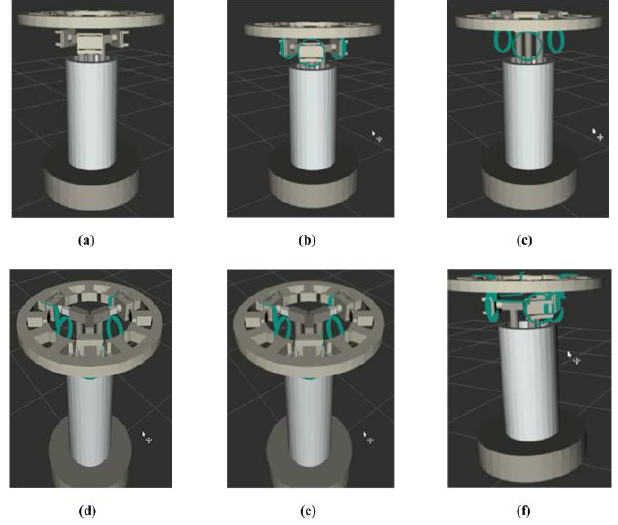
Figure 15. Simulation process diagram.